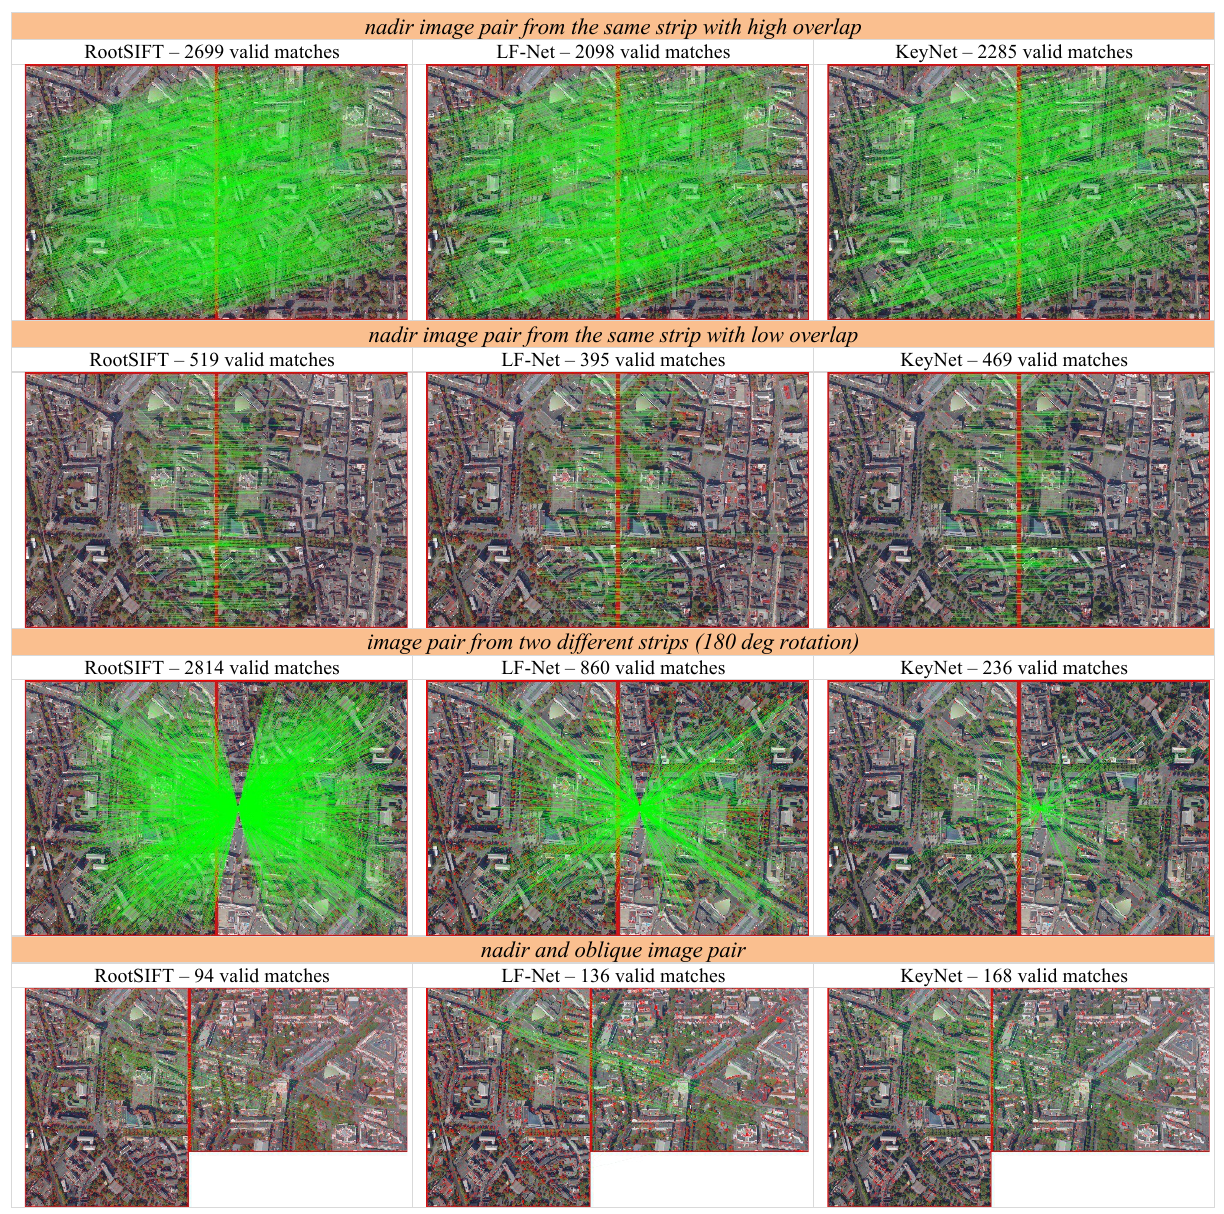
Figure 2: Tie point extraction on image pairs using hand-crafted and learning-based